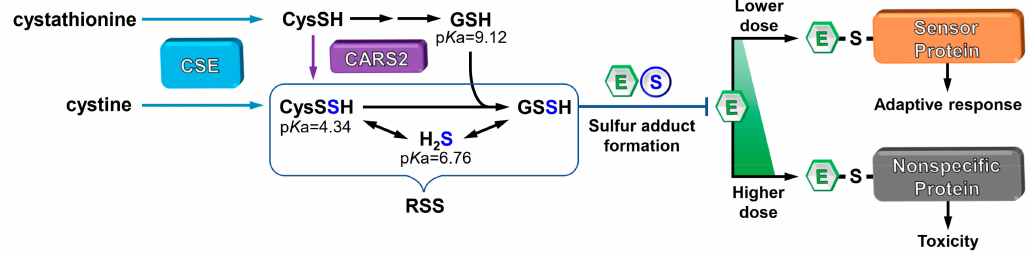
Figure 3. RSS generation and its negative regulation of covalent modification of cellular proteins by xenobiotic electrophiles. CSE- and CARS2-mediated metabolisms are shown as the blue arrows and the purple arrow, respectively. The xenobiotic electrophile-mediated activation (low dose) and disruption (high dose) of redox signaling by sensor proteins with low p K a thiols and e ff ector molecules are negatively regulated by RSS through sulfur adduct formation. E, xenobiotic electrophiles; RSS, reactive sulfur